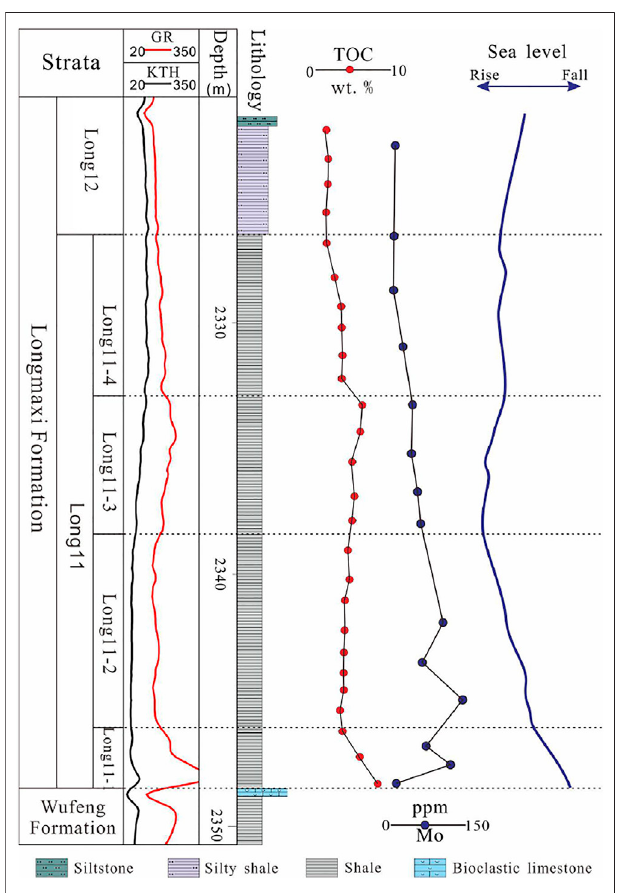
FIGURE 11 | Sea-level changes in the Longmaxi Formation in the Changning area (well N11).